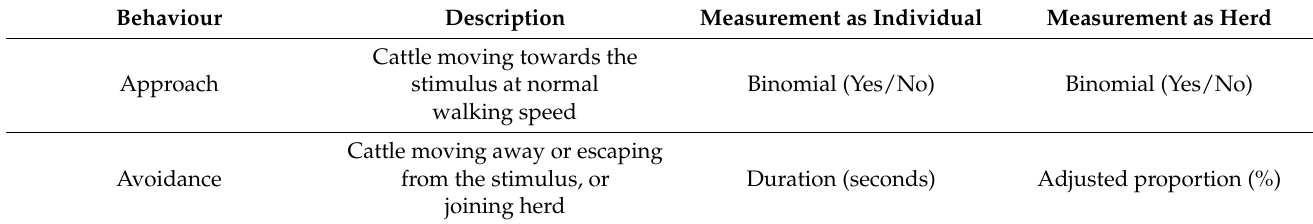
Table 4. Description and measurements of the behaviours of cattle recorded interacting with the car, koala and dog models. Adjusted proportion = aggregated behaviour duration/(test duration × total number of animals in the